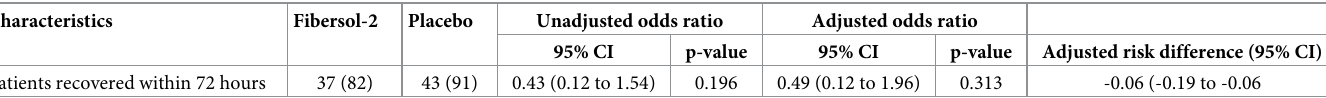
Data were n (%), unless stated